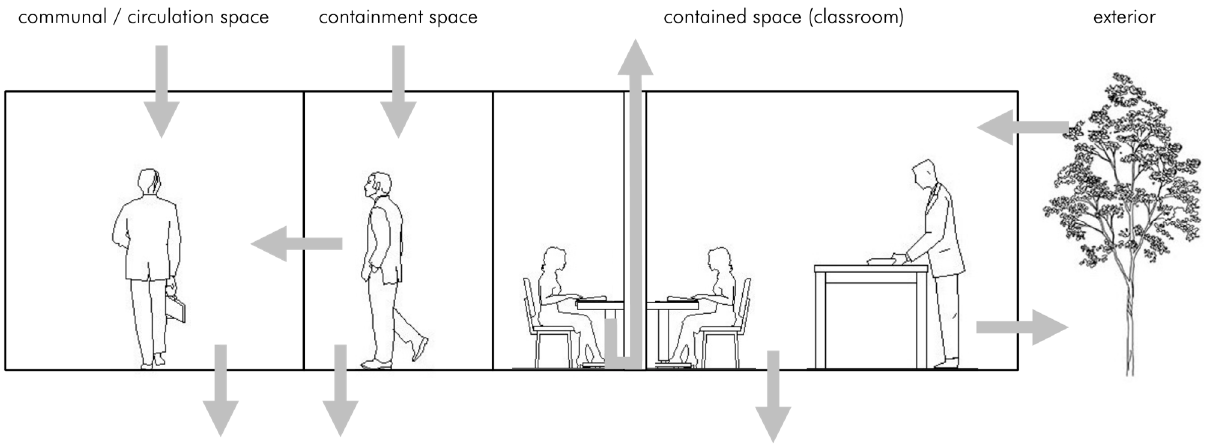
Figure 5. Conceptual model of school or office layouts with extractive vents over workspaces.